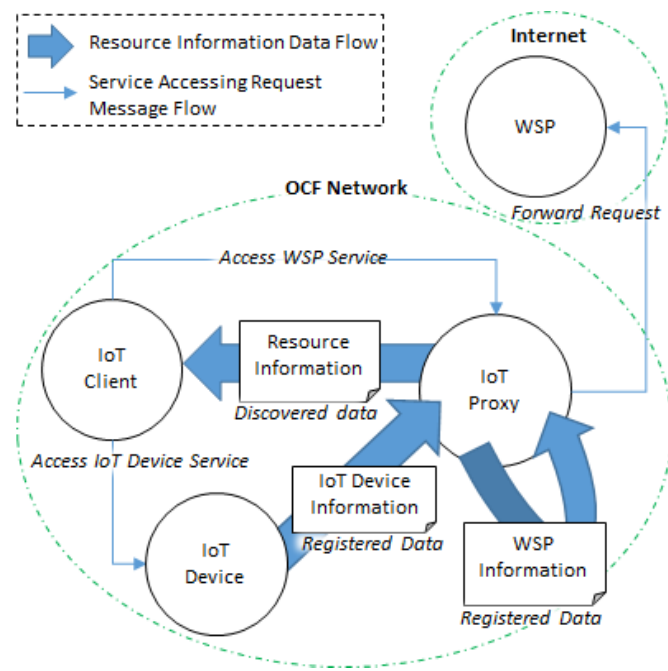
Figure 3. Interactions in the proposed IoT network model based on proxy.